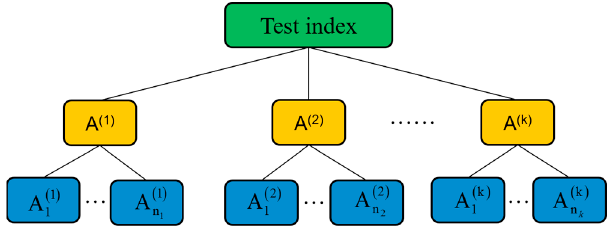
Figure 7. Orthogonal test AHP model.